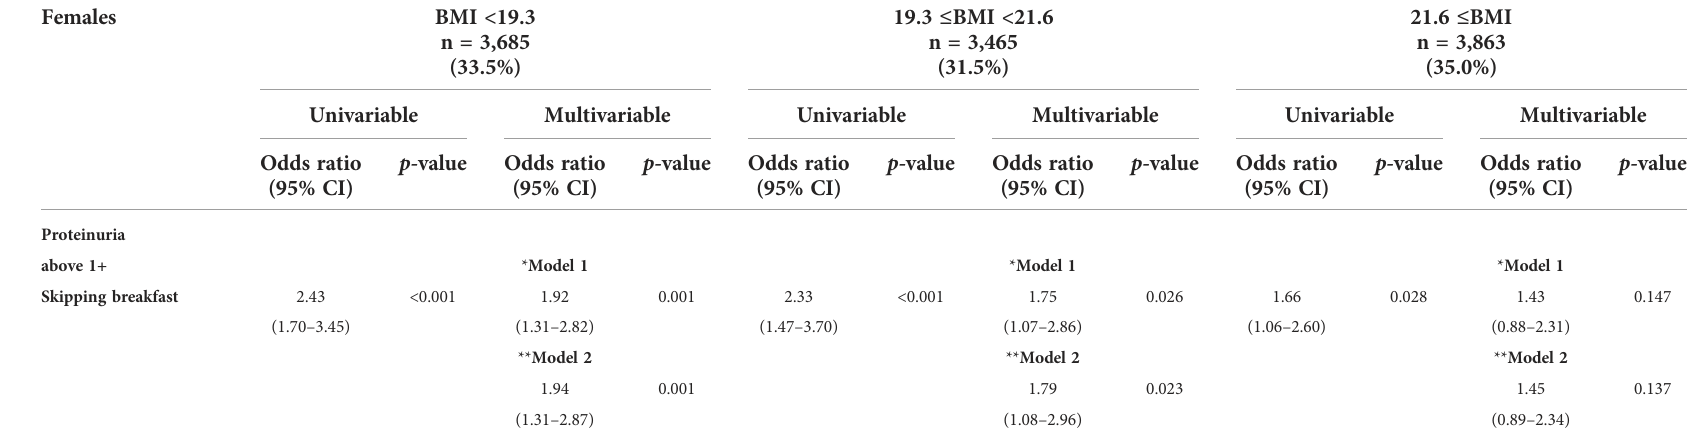
TABLE 3B Logistic regression analysis for the skipping breakfast and the prevalence of proteinuria above 1+ in 11,013 females strati fi ed by body mass index (BMI) levels. Females